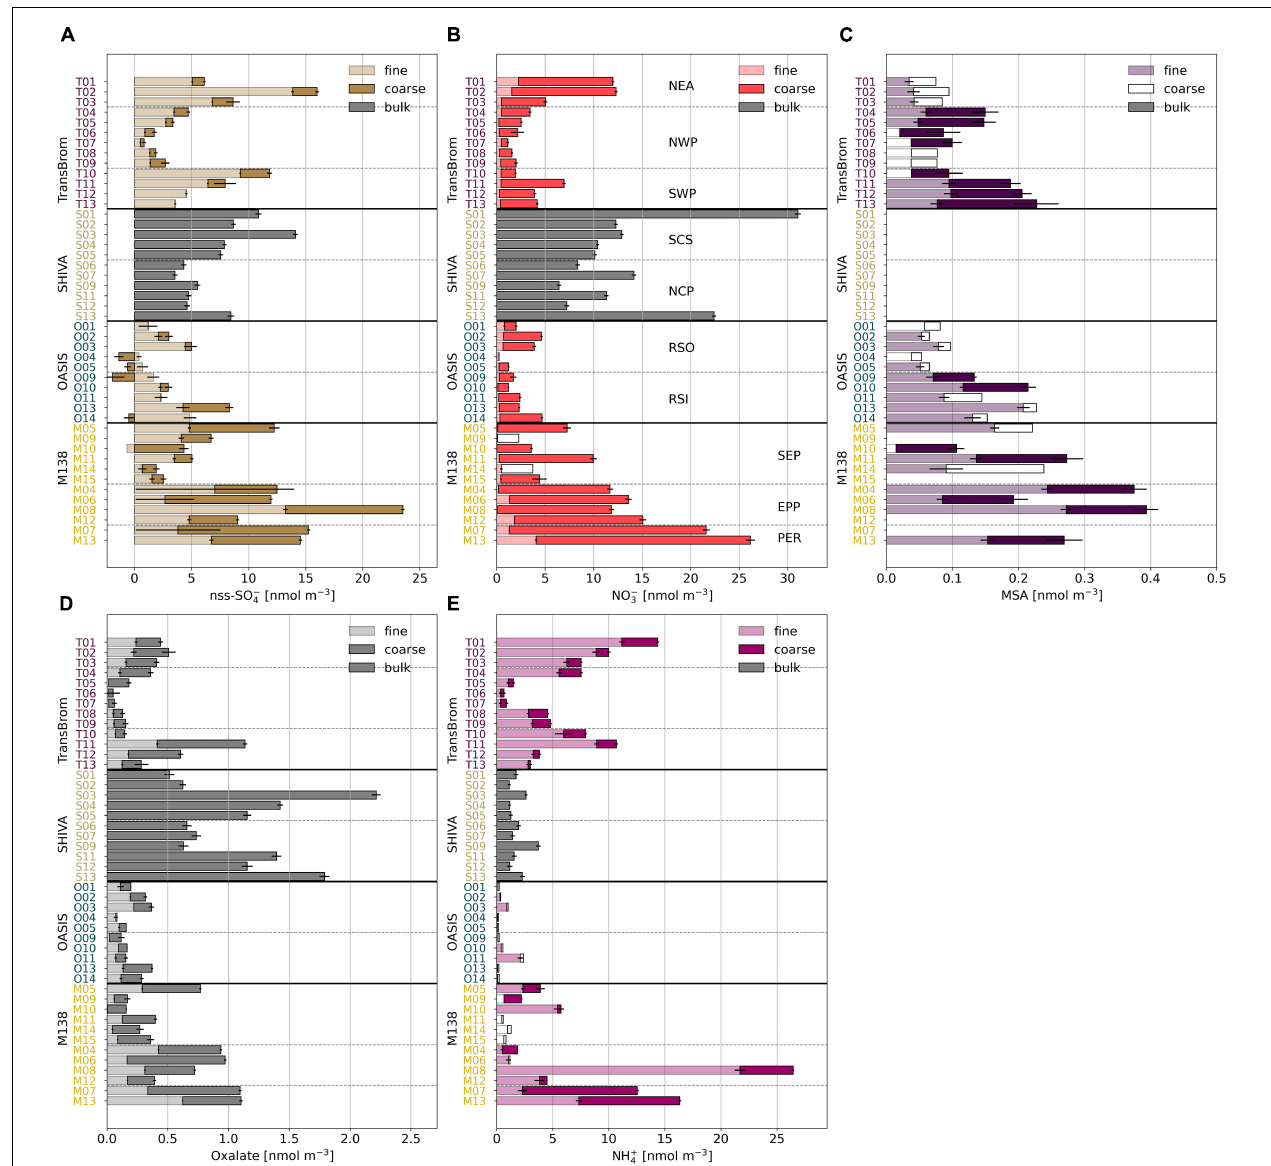
FIGURE 3 | Bar plots of (A) nss-SO 42 - , (B) NO 3 - , (C) MSA, (D) oxalate, and (E) NH 4 + in fine (light), coarse (dark), and bulk (grey) mode aerosol fractions for all samples of TransBrom (T01-T13), SHIVA (S01-S13), OASIS (O01-O14), and M138 (M04-M15). MSA was not measured in the SHIVA samples. Empty bars indicate concentrations below the detection limit. Nss-concentrations for which the error is larger than the parameter itself are omitted. Note that for M138 the sample order has been changed to allow the SEP, EPP, and PER air masses to be grouped